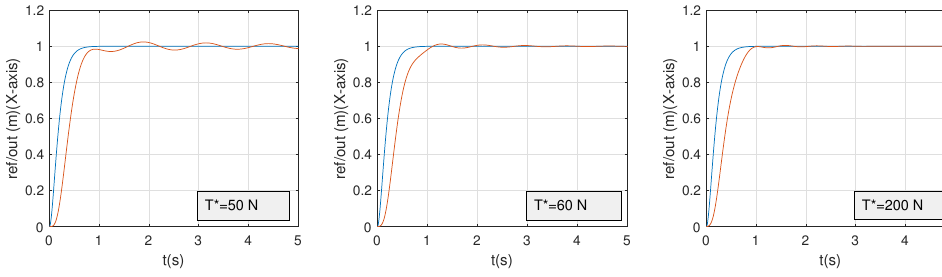
Figure 8. Effect of T ∗ on the vibration